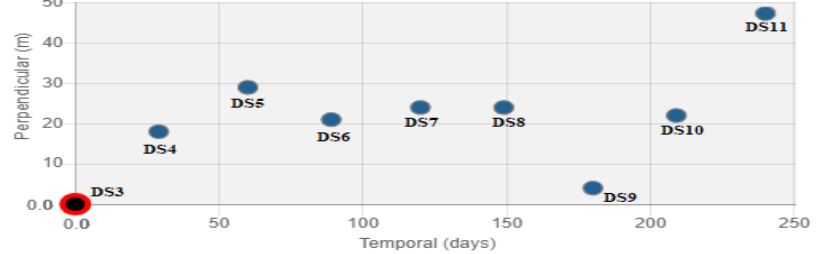
Figure 4. Perpendicular and temporal baseline of the time series data used in this study. DEM Generation with the InSAR technique